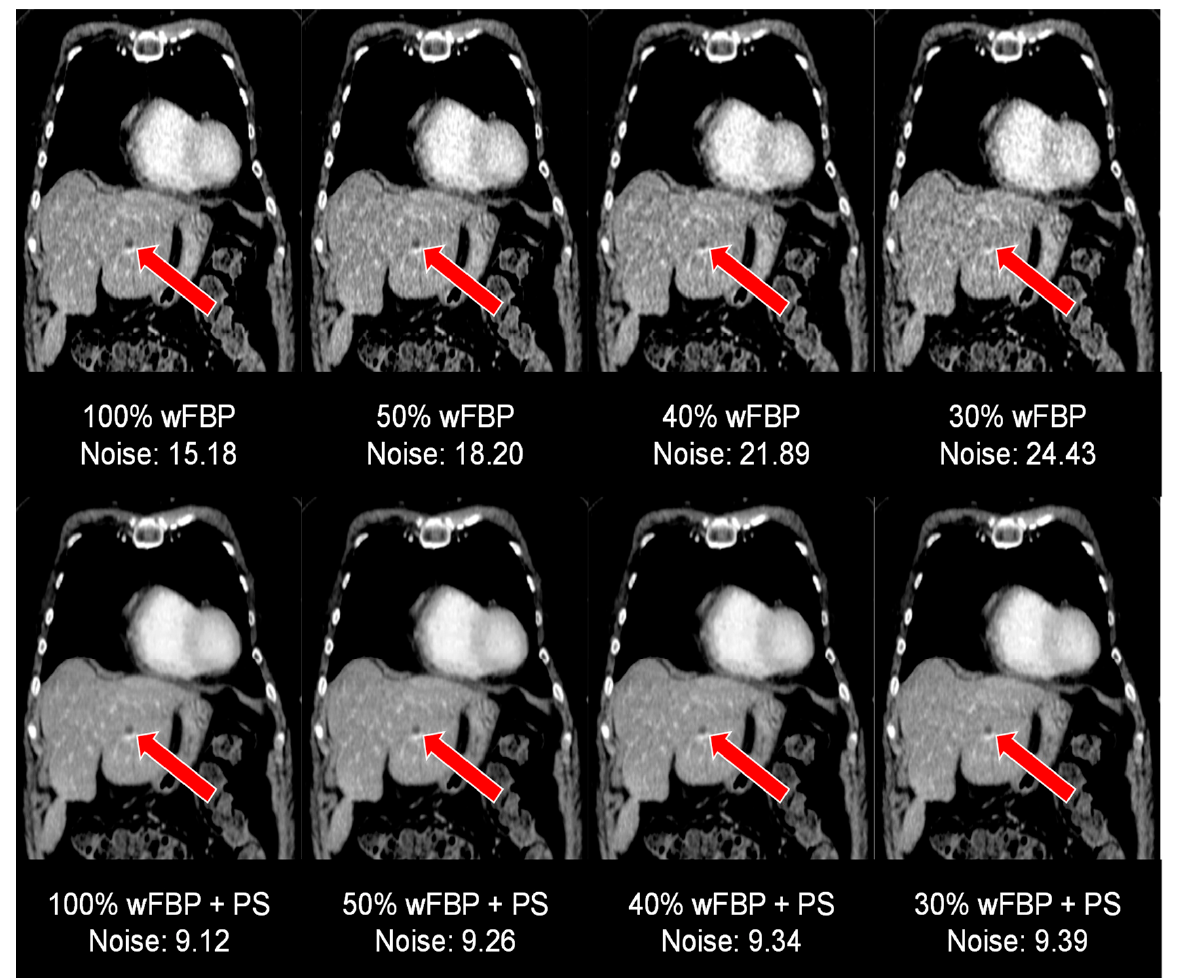
Figure 5. Image quality aspects in the setting of a hepatic melanoma metastasis at the different radiation dose levels, conventional reconstruction (top row) vs. postprocessing (bottom row). wFBP = weighted Filtered Back Projection, PS = PixelShine